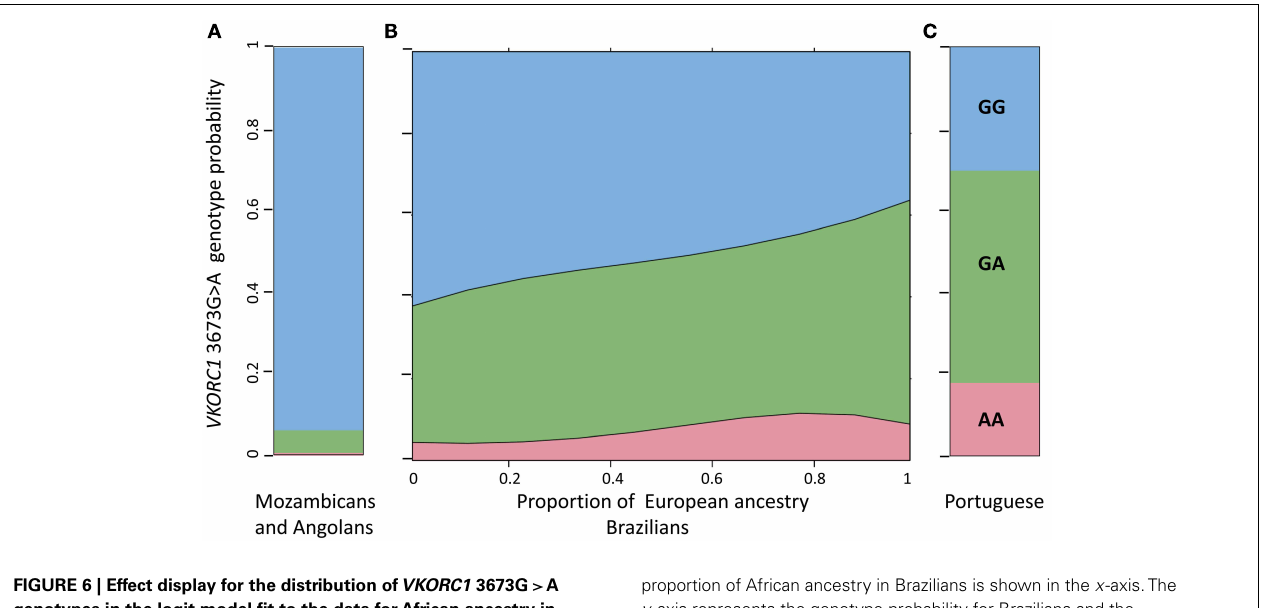
FIGURE 6 | Effect display for the distribution of VKORC1 3673G > A genotypes in the logit model fit to the data forAfrican ancestry in 965 Brazilians (B). For comparison the frequency of each genotype in a cohort of Angolans and Mozambicans [ n = 216, (A) ] and in a Portuguese cohort [ n = 89, (C) ] are also shown.The individual